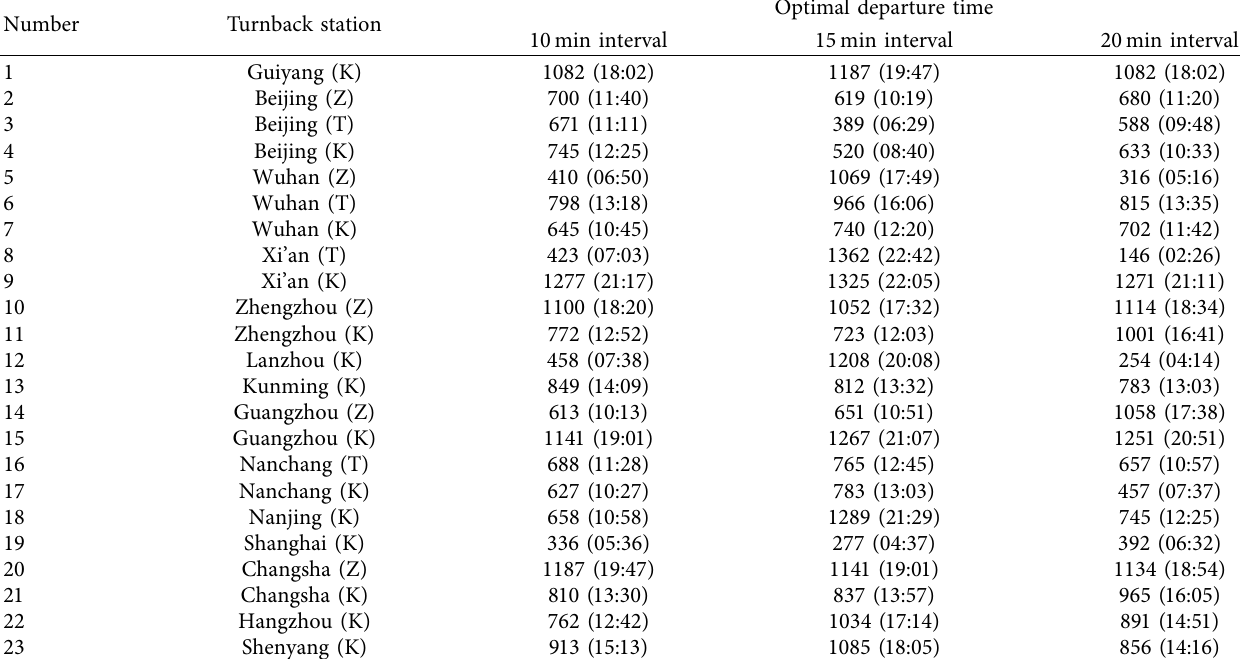
Table 5: Optimal starting timetable for passenger convenient